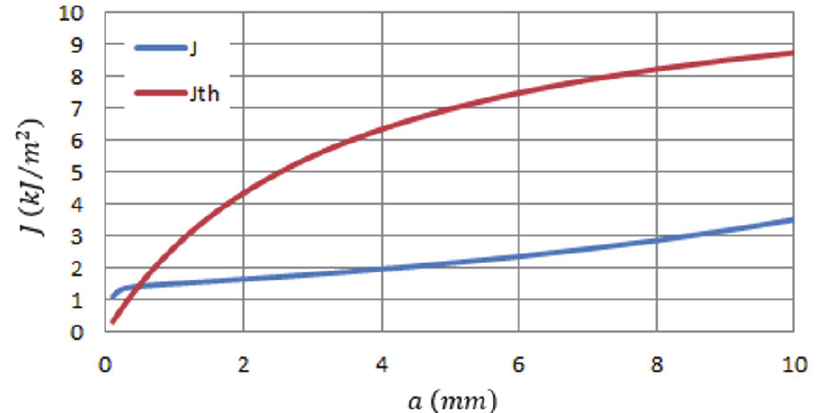
Figure 9: Curves J I (a)  a and J EACth (a)  a generated by the analysis of the DC(T) loaded by P  6kN under EP conditions.